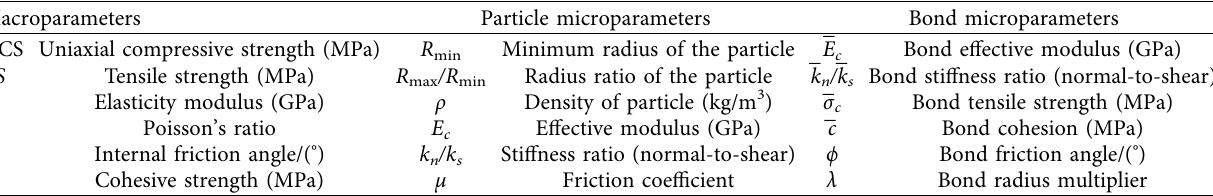
Table 2: Main macroscopic and microscopic parameters of the PBM.